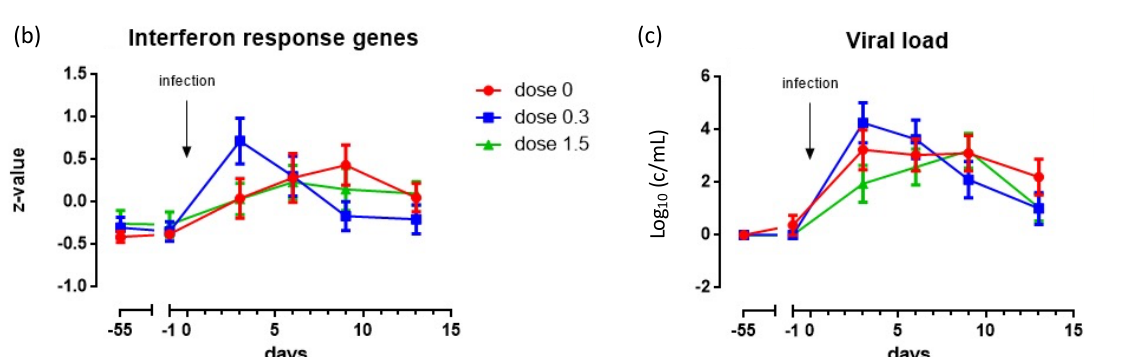
Figure 4. Summary of nested study with 16 subjects per group from whom nasal brushes were collected. Heatmaps of interferon-induced genes in nasal epithelial cells over time and as a function of the treatment ( a ). Baseline is prior to intervention; other time points are relative to the infection with RV16 (=d0; see Figure 1). Each checkerboard summarizes the data for 16 subjects of a group at a specific time point. Columns represent individual subjects (always in same order) and rows represent individual interferon response genes. In the heatmap: red and green represent up- and down-regulated genes, respectively. Black represents unchanged expression. The row below the heatmaps corresponds to total z-scores for each subject, where gradations of red indicate an increased transcription level and gradations of blue indicate a decreased level of transcription. The total z-scores (±SEM) over time as a function of the dose ( b ), and the viral load in the nasal lavage over time, as a function of the dose ( c ), are shown.